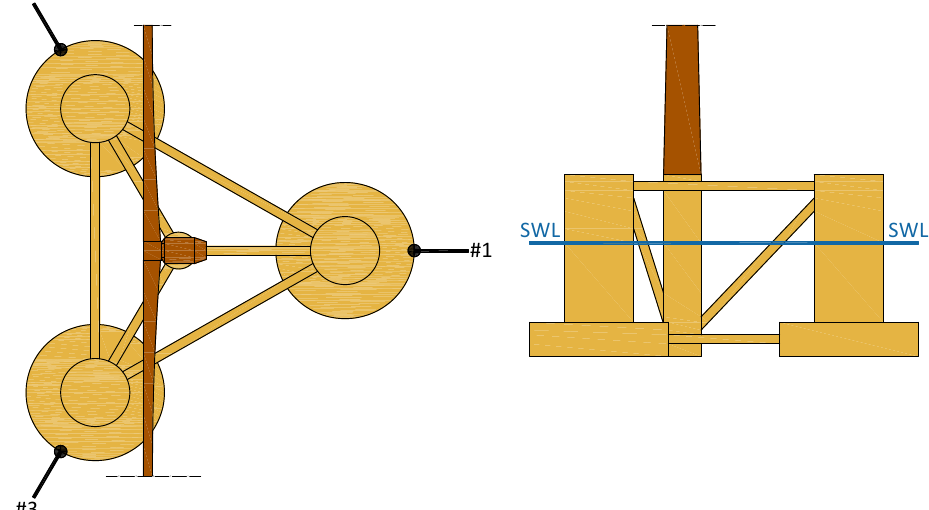
Figure 1. Reference layout of the OC4-DeepCwind platform (the symbol # means line number).